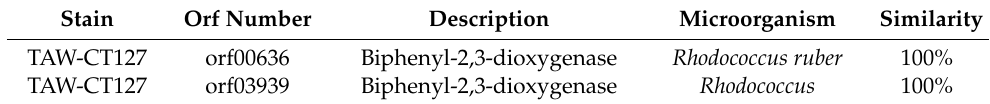
Table 4. Biphenyl-2,3-dioxygenases in the genome of strain TAW-CT127.